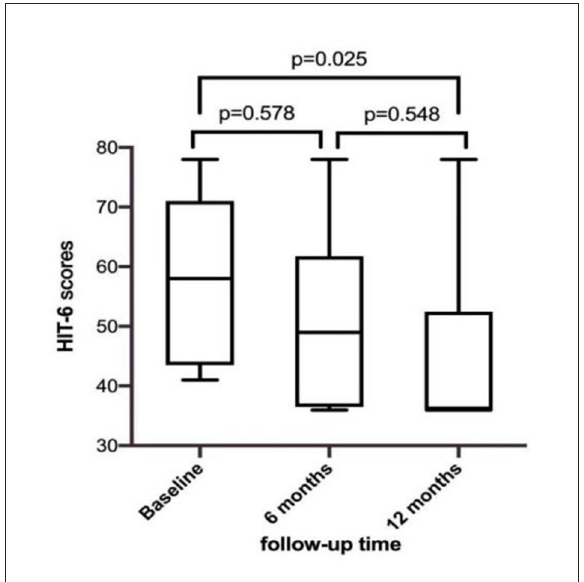
FIGURE2 Comparison of HIT-6 score in patients with migraine before and after occlusion.